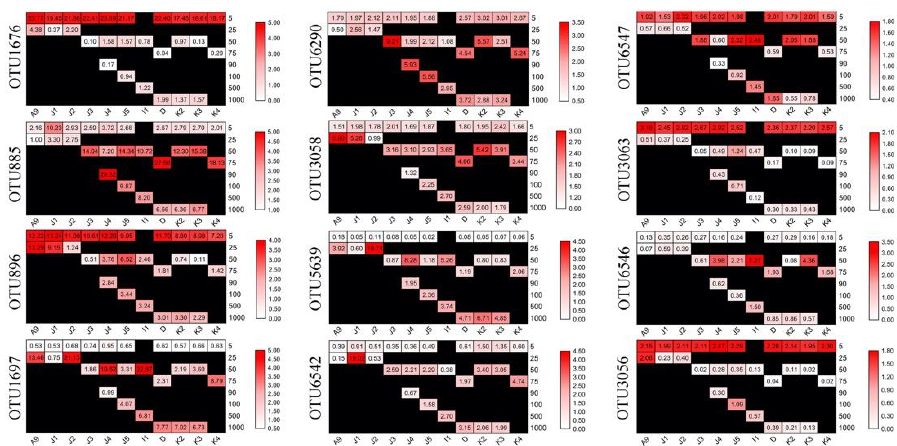
Figure 6. Heatmap showing changes of the relative sequence abundance of the 12 abundant